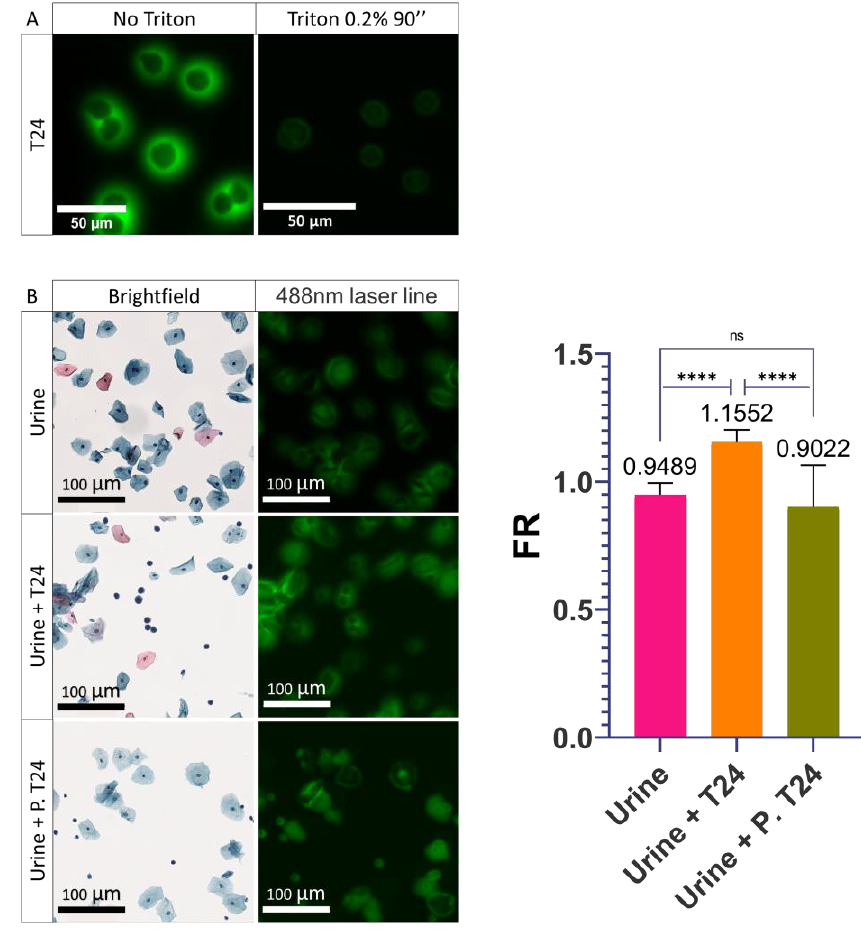
Figure 4. Influence of the permeabilization of the plasma membrane on cells. ( A ) Images acquired on confocal microscope of the permeabilization of T24 cells with 0.2% Triton for 90 seconds. ( B ) Images acquired on the scanner of healthy urine alone (Urine), supplemented with T24 cells (Urine + T24), or supplemented with T24 cells permeabilized (Urine + P. T24) with 0.2% Triton for 90 seconds and quantification of their PMF. Bar graphs represent the mean (SD) (ns > 0.05; **** p <